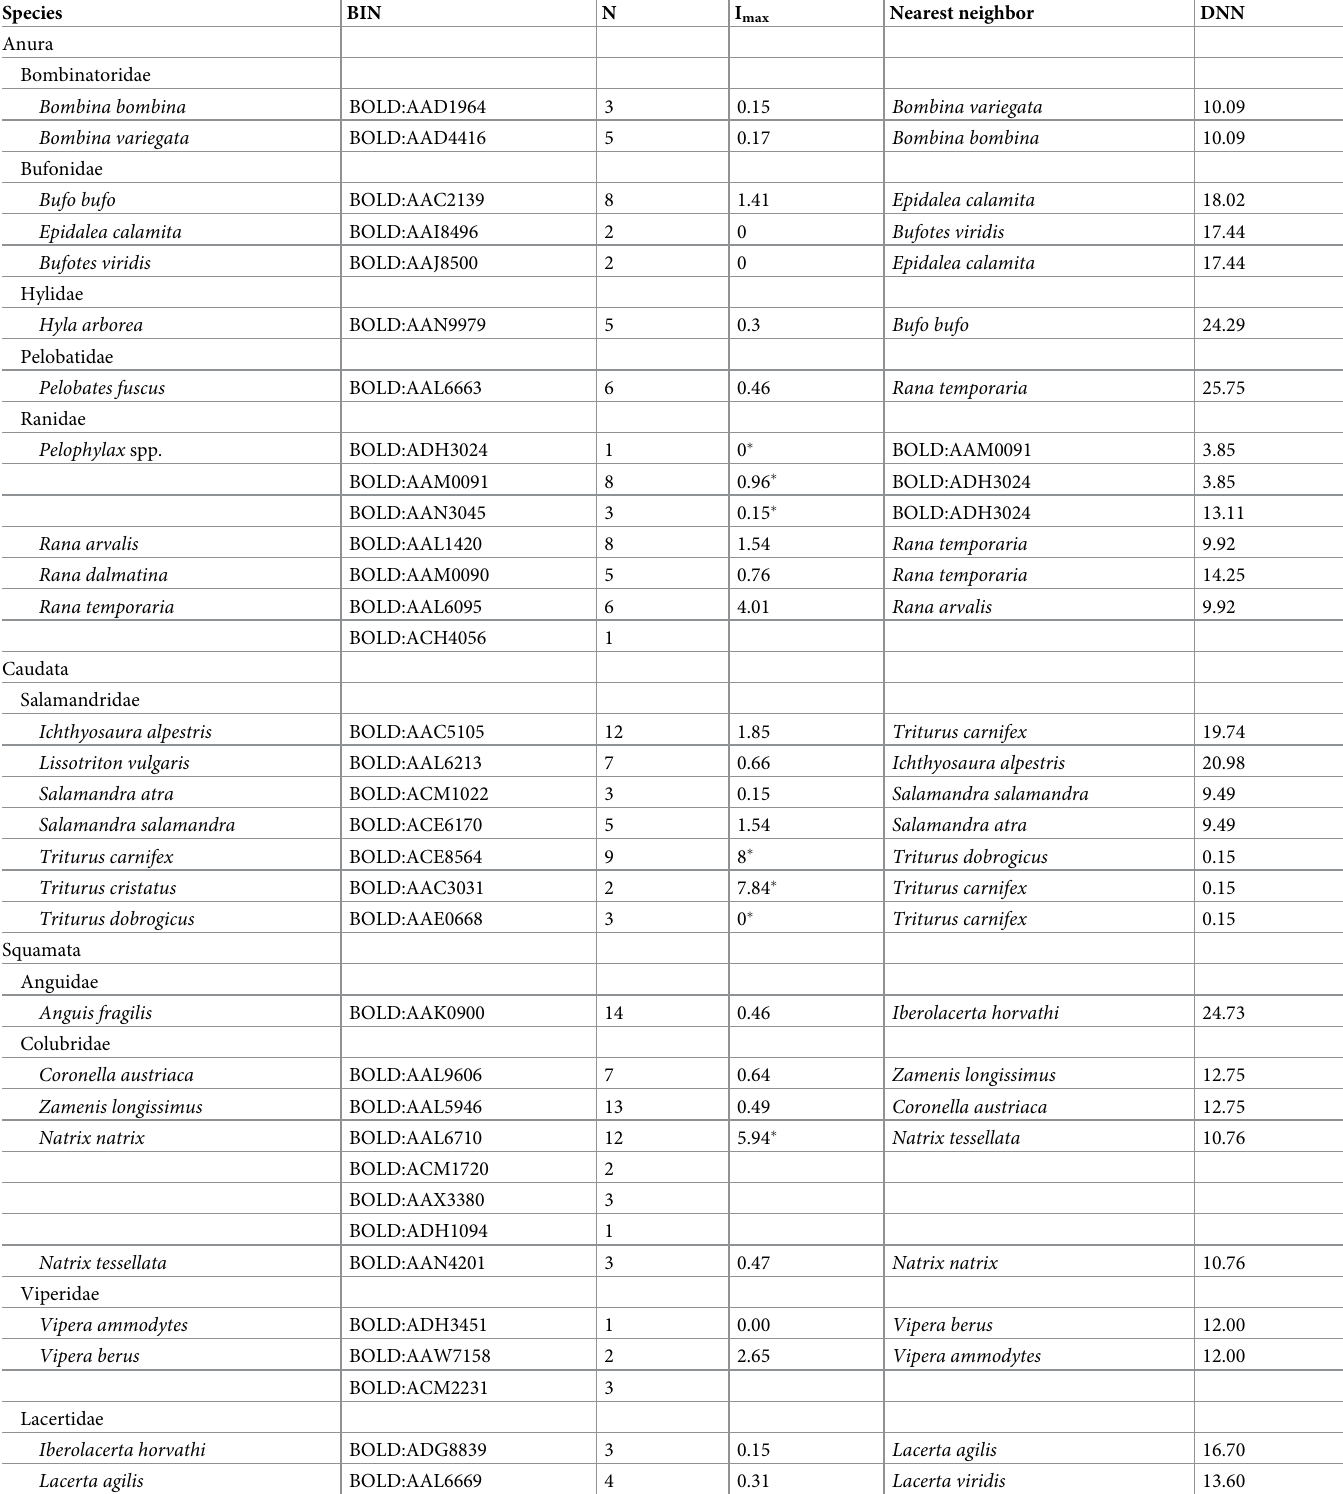
Table 1. Genetic (K2P) distances (in %) within and between species.